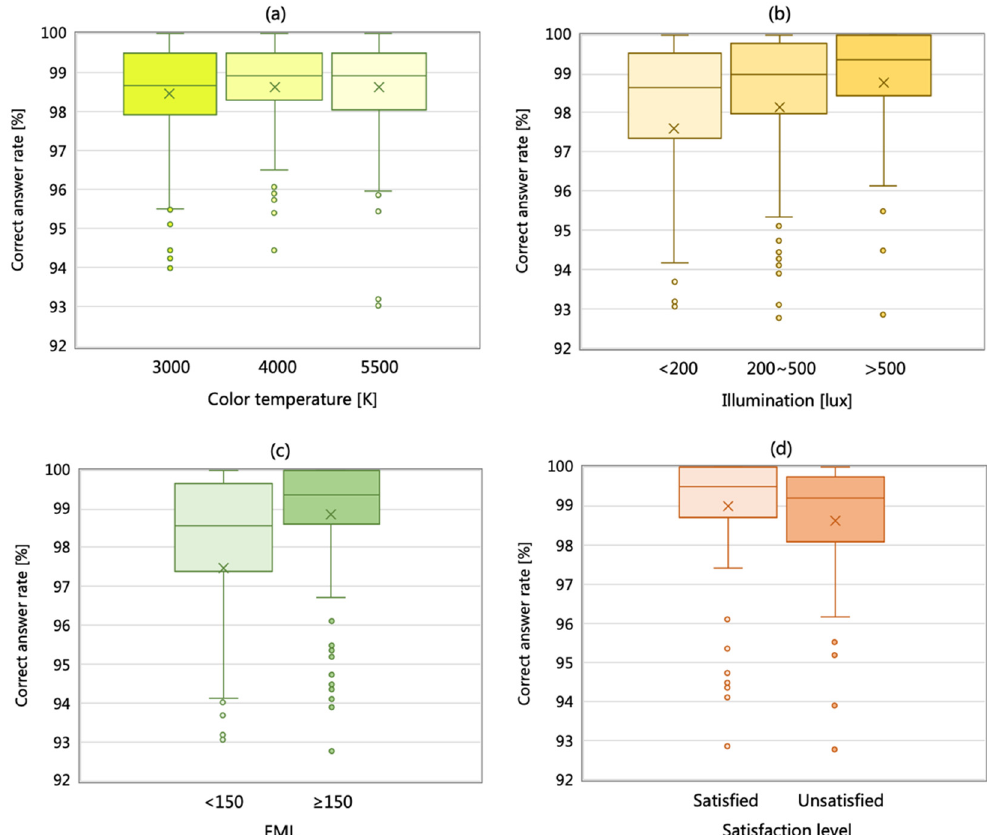
Figure 4. Correct answer rates of different CCTs, illumination, EML, and satisfaction level: ( a ) The effect of CCTs on work productivity; ( b ) The effect of illuminance on work productivity; ( c ) The effect of sufficient and insufficient 150 EML on work efficiency; ( d ) The effect of a comfortable lighting environment on productivity under the condition of sufficient 150 EML.